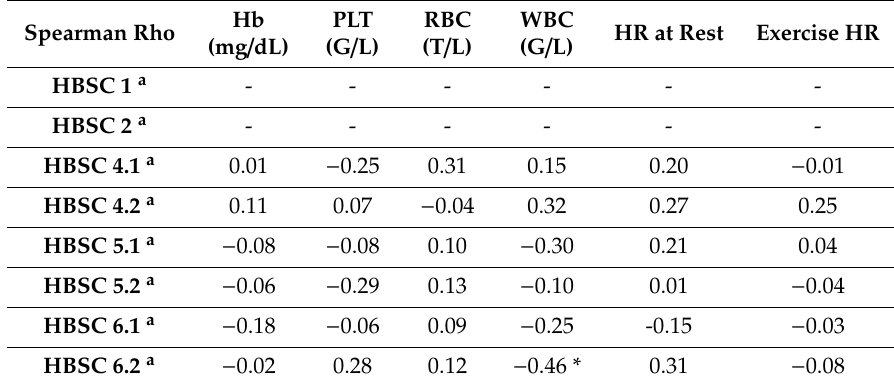
Table 10. Correlation between the survey results that assessed the level of physical activity and sedentary behaviors and blood count parameters and heart rate in the study group of children in total. Values of p < 0.05 were considered statistically significant. a The question content of the HBSC questionnaire is given in Table 7.